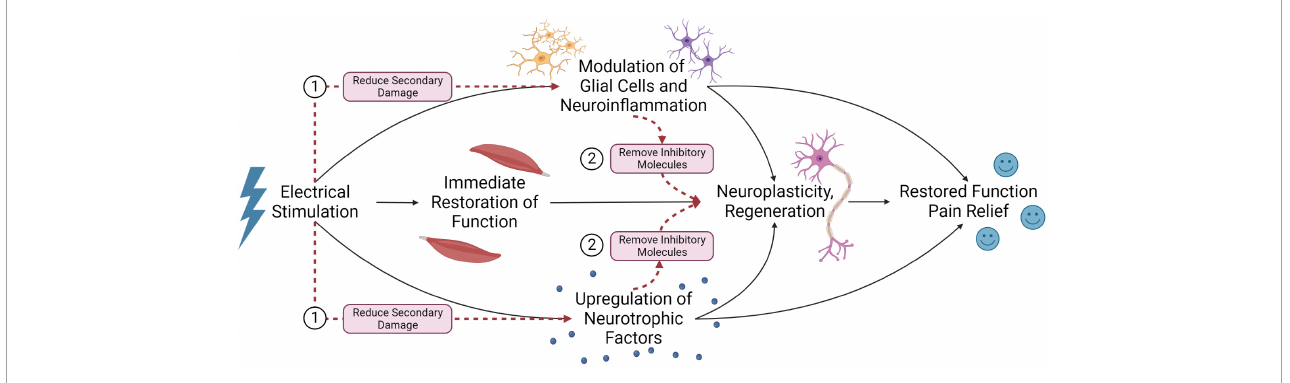
FIGURE8 Alternative mechanisms that may contribute to functional recovery post SCI. (1) Providing acute electrical stimulation may reduce secondary damage through neuroinflammatory and vascular events. (2) Electrical stimulation may remove inhibitory molecules around the lesion site to